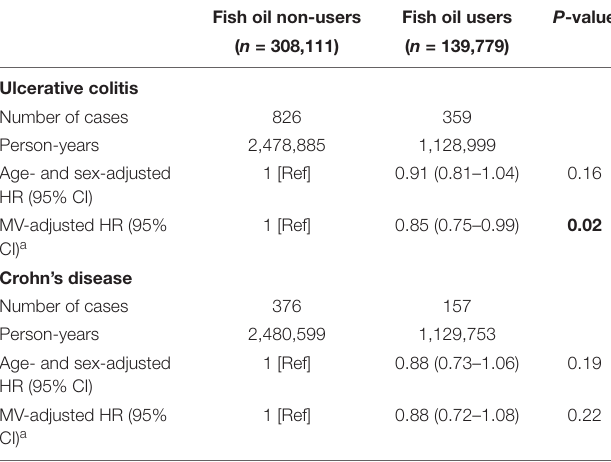
TABLE 3 | HRs (95% CIs) of ulcerative colitis and Crohn’s disease according to fish oil use in the UK Biobank. Fish oil non-users Fish oil users